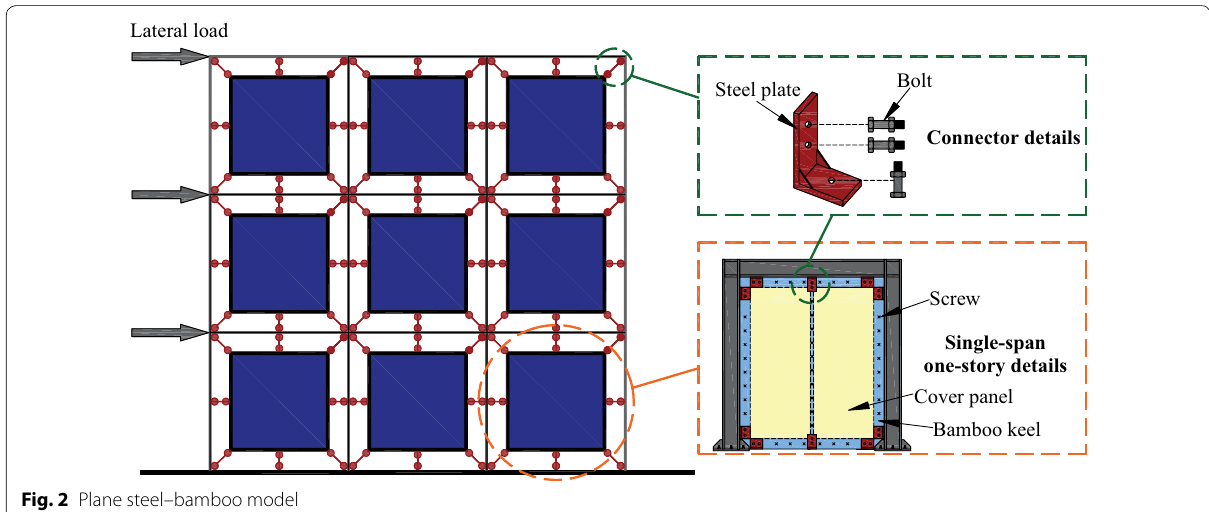
Fig. 2 Plane steel–bamboo model